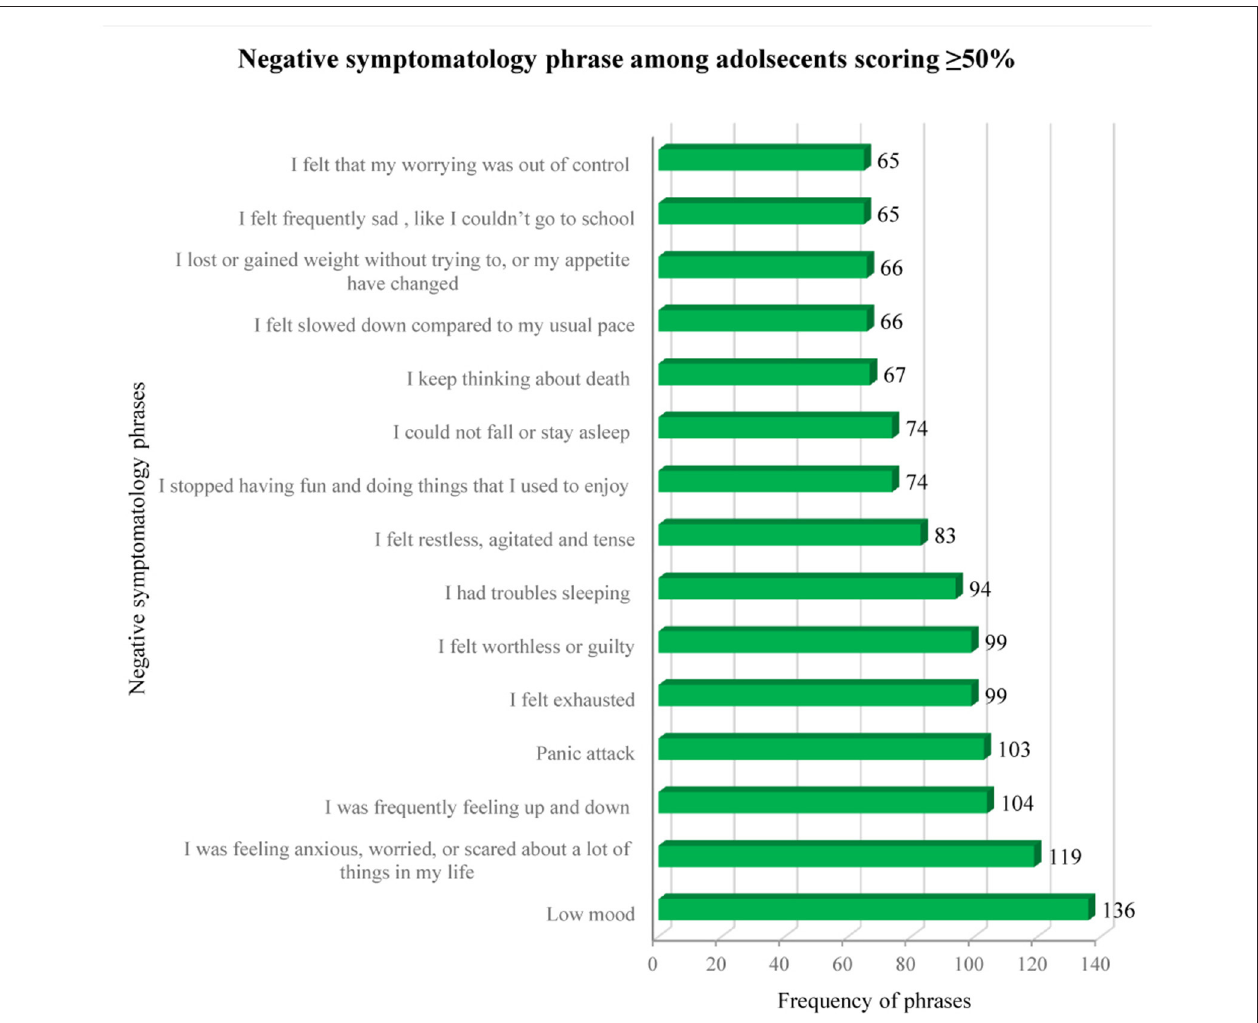
FIGURE 1 | Frequency of negative symptomatology phrases among adolescents with feeling scorings ≥ 50%.